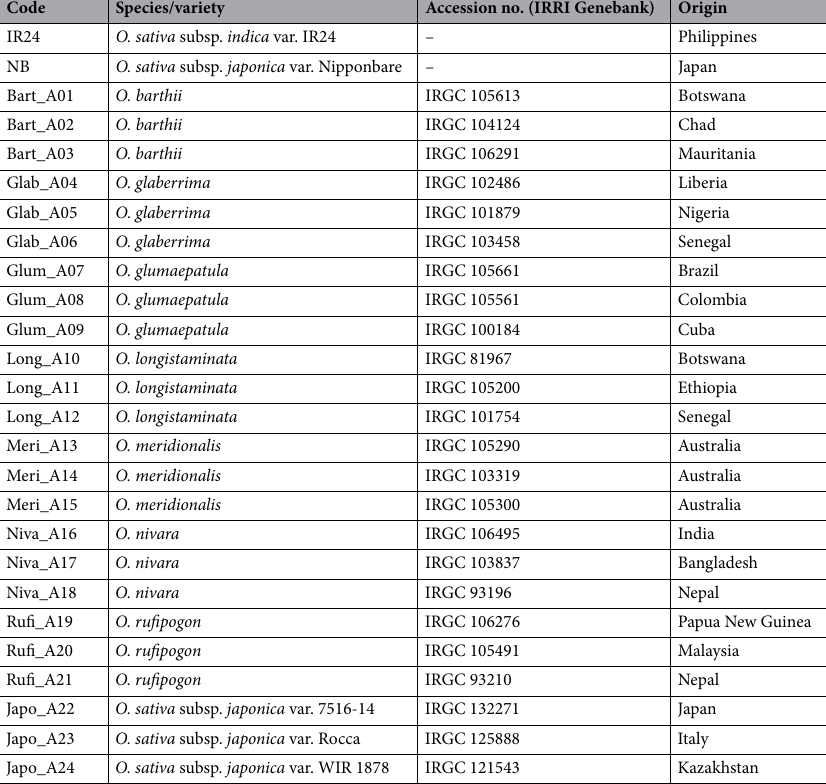
Table 1. List of AA-genome germplasm used in this study for experimental marker